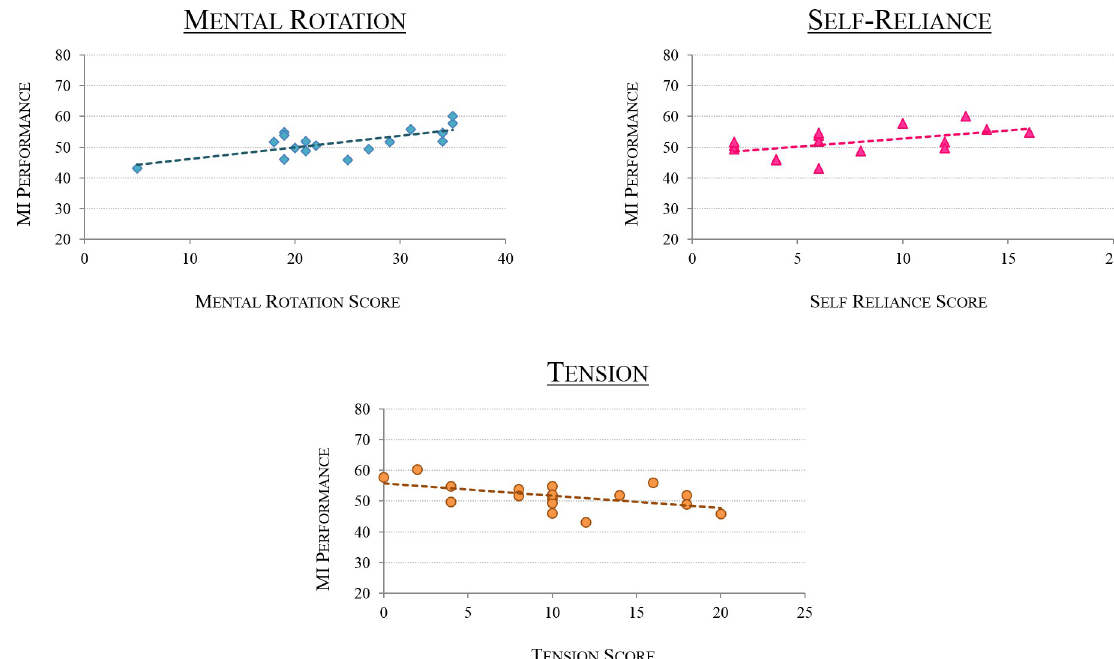
Fig 3. MI-BCI Performance as a function of personality profile. Graphs representing the participants’ MI-BCI performances as a function of (1) Mental Rotation scores -top left-, r = 0.696; (2) Self-Reliance -top right-, r = 0.514; (3) Tension -bottom-, r = -0.569.